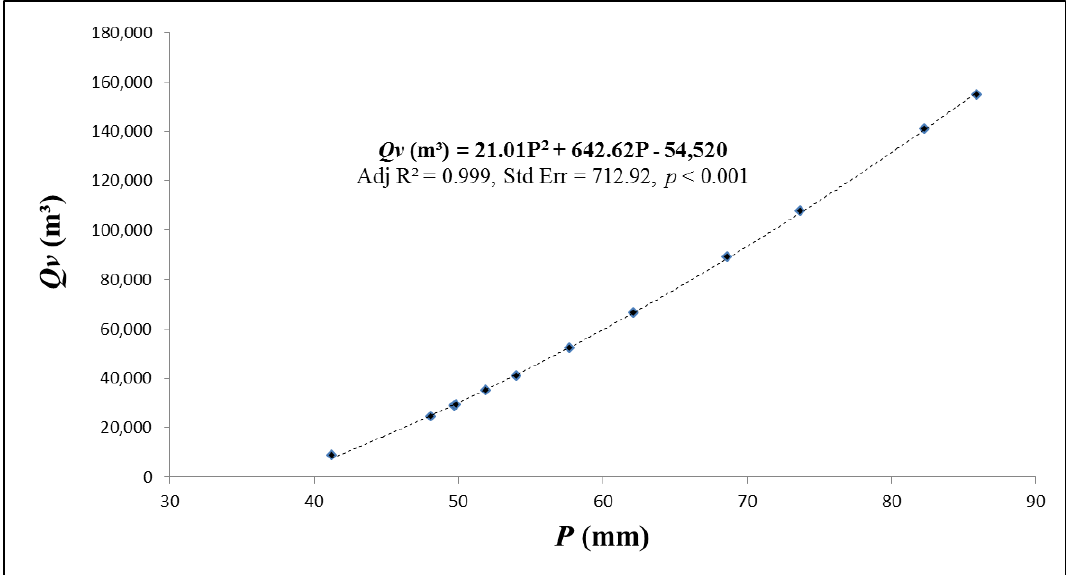
Figure 4. Runoff volumetric differences between the proposed, calibrated SCS - CN model and the conventional SCS - CN